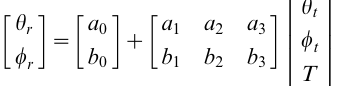
The horizontal and vertical components of the red line shown in Figure 3B are the group averaged values of a 3 and b 3